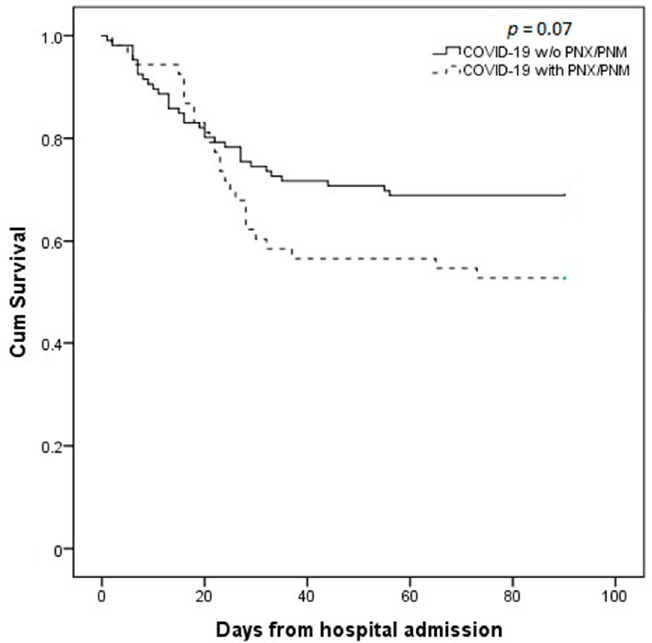
Figure 3. Kaplan–Meier survival curve comparison between patients who developed PNX/PNM and patients who did not, at 90 days from hospital admission. Continuous line represents COVID-19 without PNX/PNM, while dashed line represents COVID-19 patients with PNX/PNM. Survival curves are not statistically different, although a trend is observed ( p = 0.07).